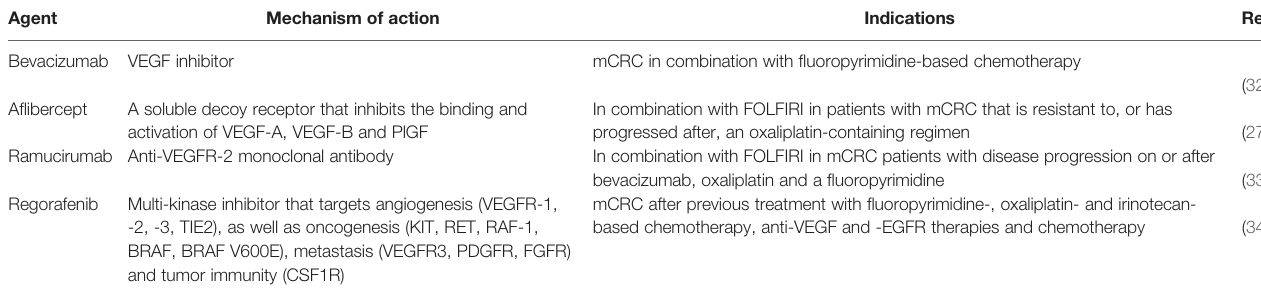
TABLE 1 | Antiangiogenic agents currently approved for the treatment of mCRC in